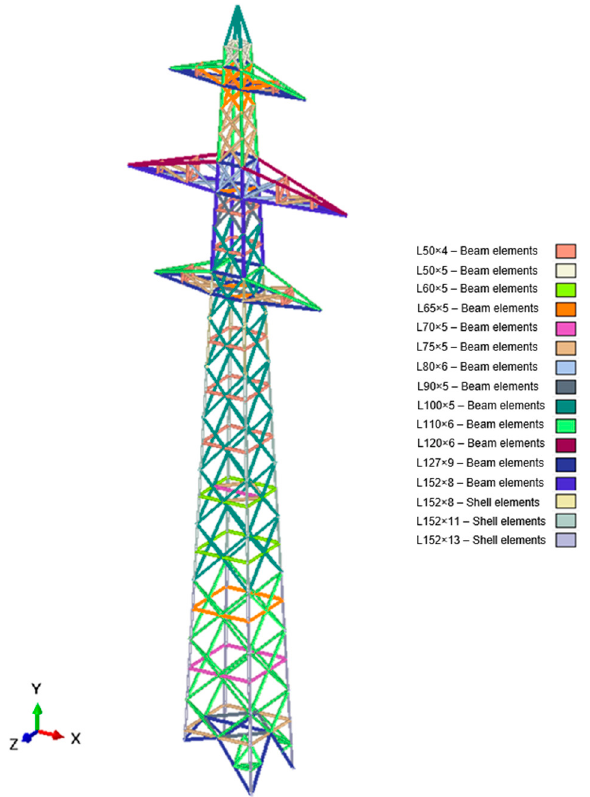
Figure 15. Tower geometry, sections (entirely L-section members, dimensions flange width × flange thickness) and mesh element types (shell and beam).